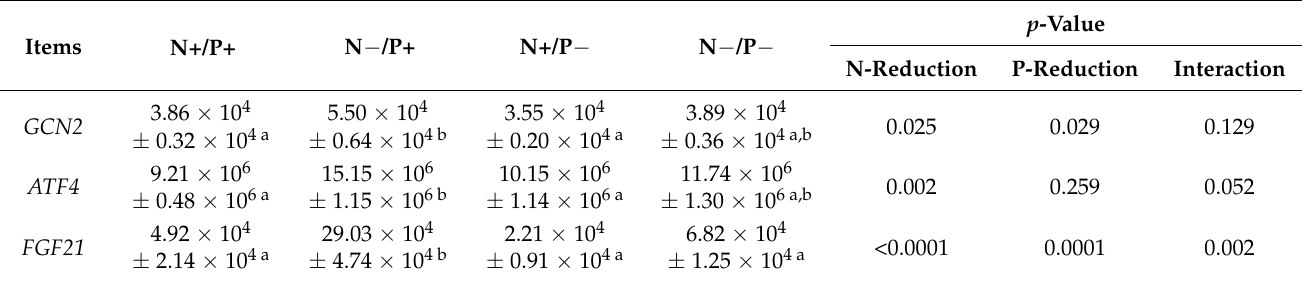
GCN2 (general control nonderepressible 2), ATF4 (activating transcription factor 4). Expression levels of target genes were normalized to 18S / RPL19 . Mean values ± standard errors. n = 7 animals. a,b Mean values within a row with different superscript letters were significantly different; Tukey’s multiple comparisons test ( p < 0.05).